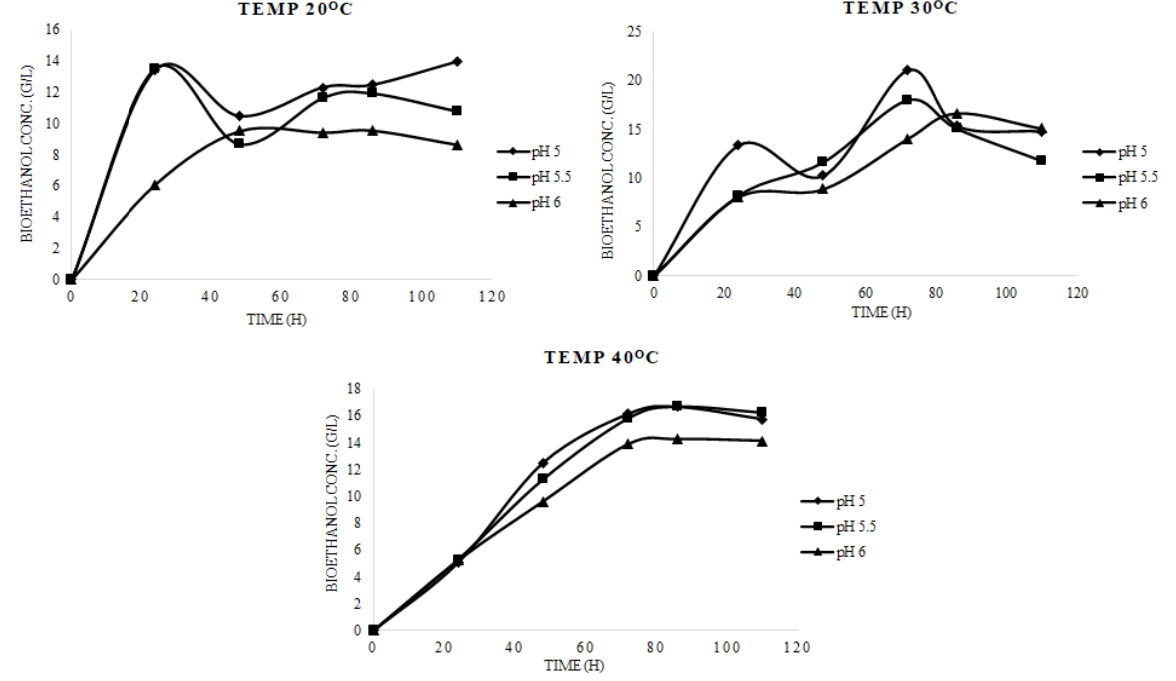
Figure 7. Effect of time, temperature, and pH on bioethanol production using P. pastoris .